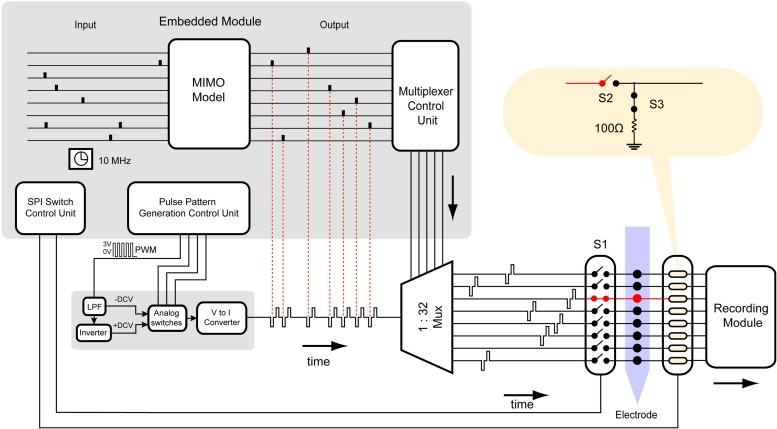
Block diagram and data stream of the multi-channel neurostimulator with SAS. The hardware is programmed by the embedded system to generate highly configurable constant current monopolar biphasic-pulse stimulation. Each block in the embedded system represents an algorithm to control the hardware. It consists of a MIMO non-linear dynamical model simulator, using a random number generator (RNG). The data is inputted to a multiplexer control unit to set the appropriate select lines of the multiplexer. The multiplexer control unit is synchronized with the SPI switch control unit to control CMOS switches.